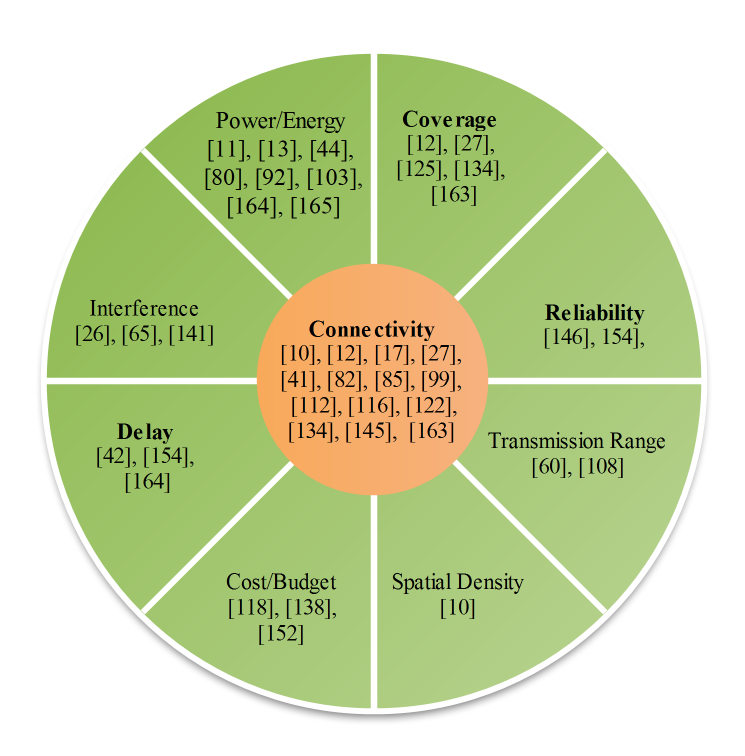
Figure 4. Constraints used to formulate optimization problems in